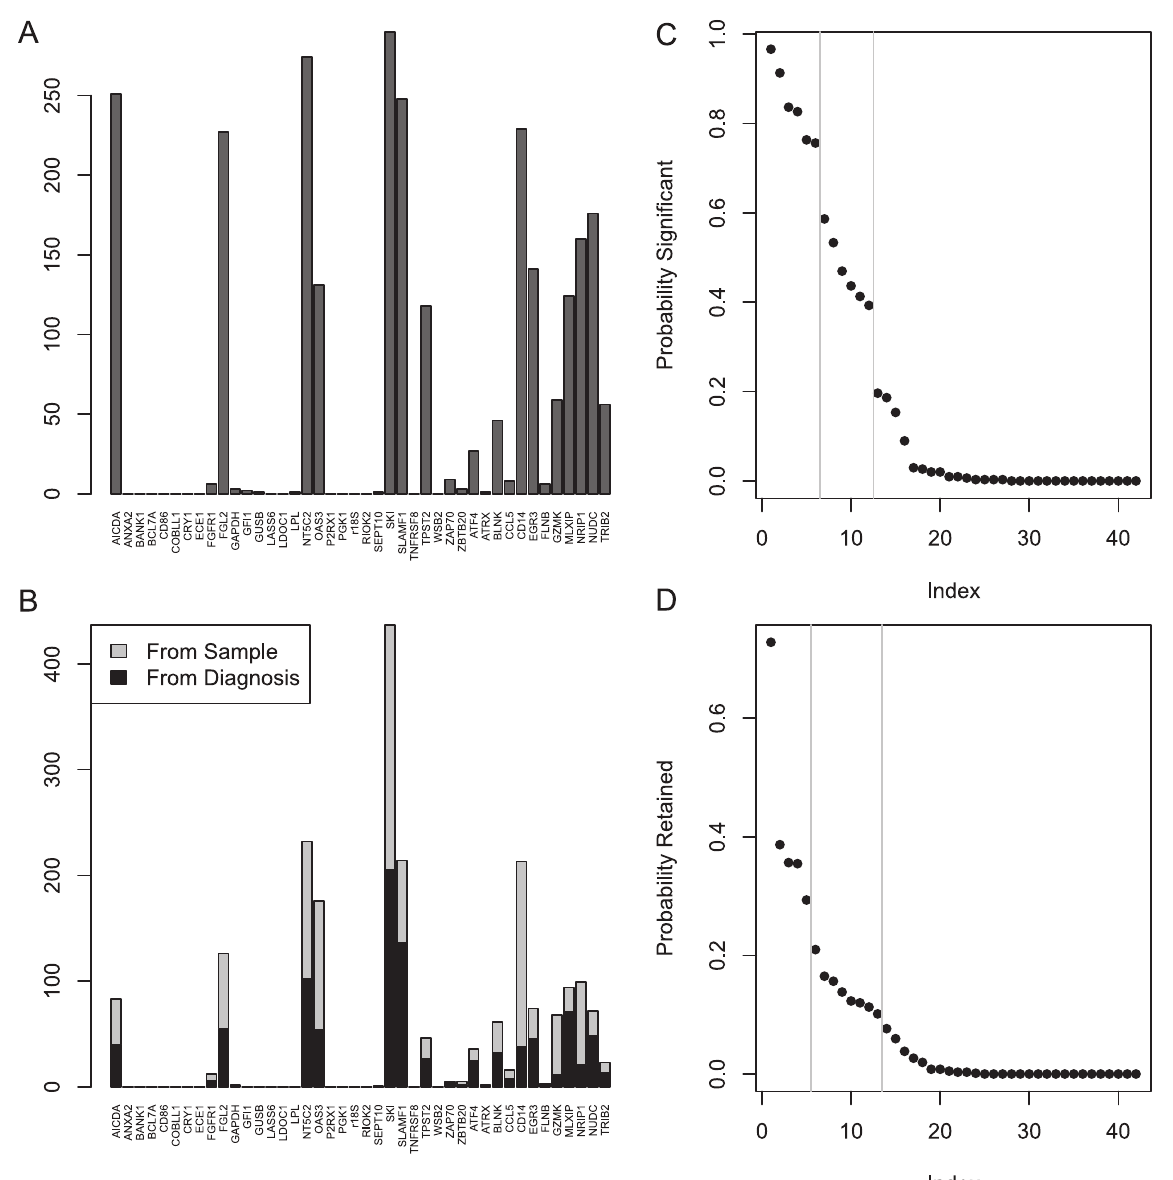
Figure 1. Cross-validation of gene predictors on the training set. (A) Histogram of the number of times each gene was statistically significant among 300 assessments of univariate models. (B) Histogram of the number of times each gene was retained in a multivariate model to predict time- to-treatment either from diagnosis or from sample collection (300 each). (C) Sorted probabilities that a gene was significant in a univariate model. Gaps in the figure identify a six-gene and a twelve-gene subset. (D) Sorted probabilities that a gene was retained in a multivariate model. Gaps in the figure identify a five-gene and a thirteen-gene subset.